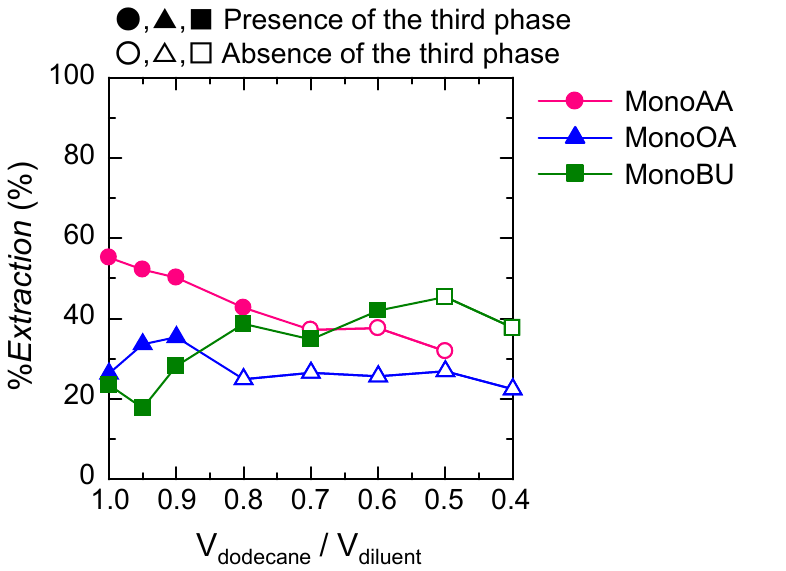
Figure 5. Effect of composition of the organic phase diluent on the extraction percentage of Pt(IV) by MonoAA, MonoOA, and MonoBU. [Extractant] org,i = 1.0 M in n -dodecane/2-ethylhexanol (100 vol%/0 vol%–40 vol%/60 vol%), [Pt(IV)] aq,i = 0.292 M, [Ir(III)] aq,i = 9.64 × 10 − 3 M, [Rh(III)] aq,i = 0.116 M, [Cu(II)] aq,i = 0.262 M, [HCl] aq,i = 2.0 M. Figure 6 shows the effect of the phase ratio of organic to aqueous phases on the extraction of Pt(IV) by MonoAA, MonoOA, and MonoBU. In all extraction systems, the extraction percentage of Pt(IV) increased with the phase ratio of the organic phase. In the MonoAA and MonoBU systems, the third phase was formed in all volume ratios of the diluent, whereas in the MonoOA system, no third phase was formed. This is thought to be due to MonoOA’s longer alkyl chains than other extractants, which results in higher solubility MonoOA and Pt(IV) extracted complexes in the organic phase.